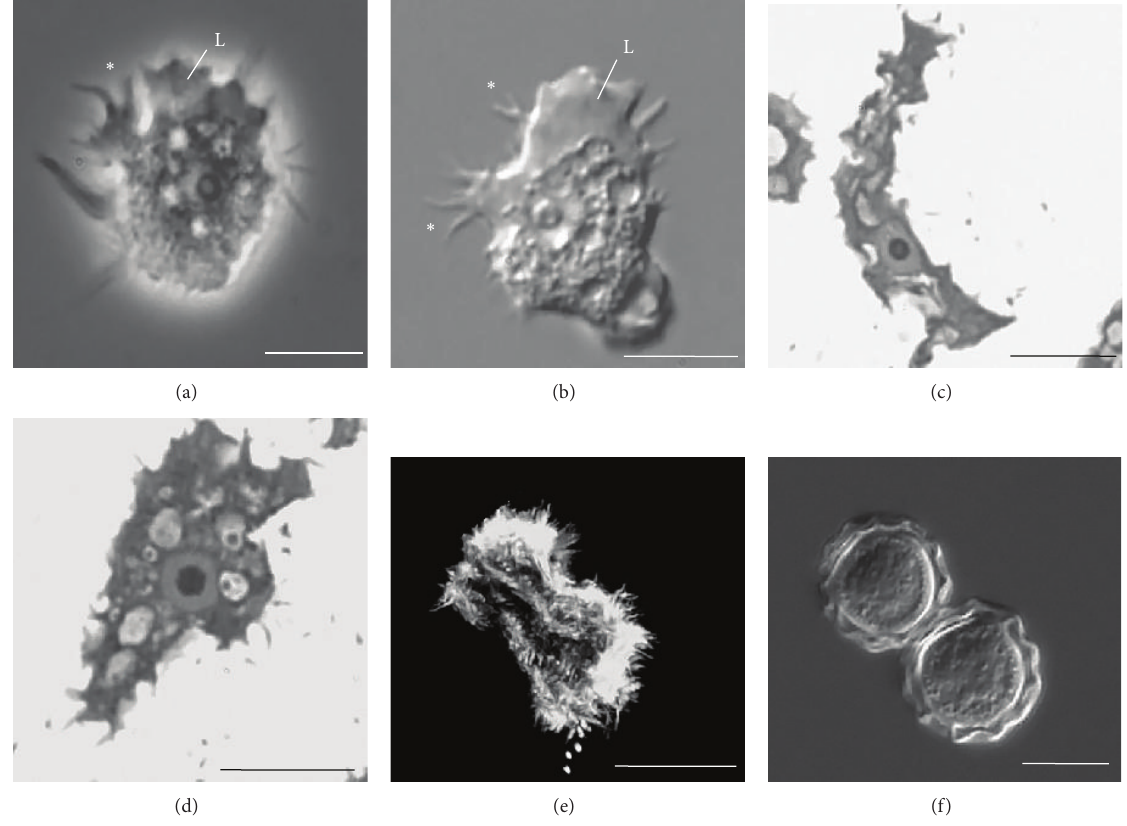
Figure 1: Light and confocal microscopy of Acanthamoeba griffini trophozoites. Phase contrast (a) and differential interference-contrast (b) microscopy of a live A. griffini trophozoite exhibiting an irregular morphology. A large lamellipodium (L) of smooth appearance as well as several thin and slender acanthopodia that are frequently bifurcated ( ∗ ) are seen. (c) and (d) Toluidine blue stained thick resin sections of trophozoites. The morphology of the trophozoites is very diverse, ranging from slender to oval. In both amoebae a single large nucleus along with a round dark nucleolus and numerous vacuoles with diverse content are observed. (e) A trophozoite observed by confocal microscopy after treatment with phalloidin-rhodamine complex exhibiting a positive strong reaction to actin. This protein is located in cytoplasmic projections but it is also detected all around the cell body. (f) Differential interference-contrast image of A. griffini cysts with showing clearly defined thick wavy layers located near the rounded